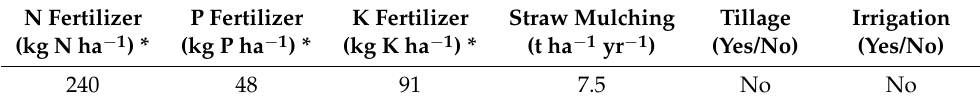
Figure 1. Field layout for experimental plots, 15 N labeling and soil/gas sampling. The dark grey area indicates the plots selected in this study. Four squares in each plot represent the stainless steel frames used to measure N gas fluxes and sample soil. Table 2. Field cropping managements in this study.